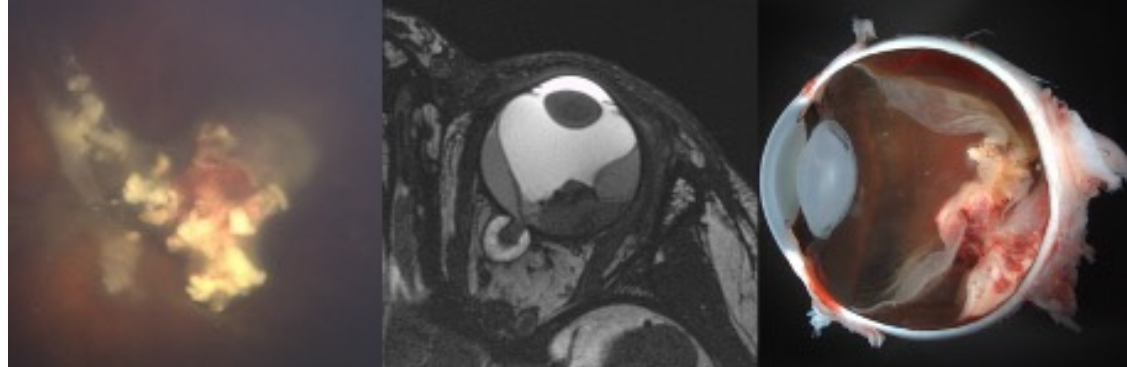
Figure 2. (Case 11): The first picture shows a clinical evident tumor recurrence of the centrally located type III regression 8 months after proton beam therapy. The second picture shows the corresponding MRI images with the prominent tumor and a total exudative retinal detachment. The third picture shows the macroscopic images after enucleation with a visible massive choroidal infiltration only detected by histopathological workup of the specimen.